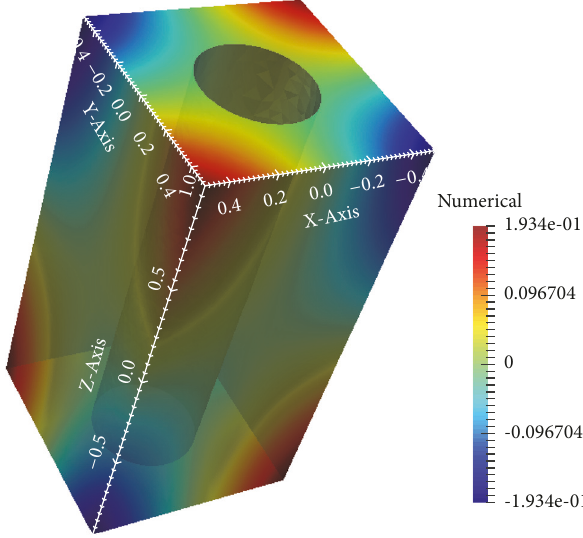
Figure 14: The numerical solutions 𝑢(𝑥,𝑦, 0) with 𝑇 = 1 , 𝜏 = 0.2 .